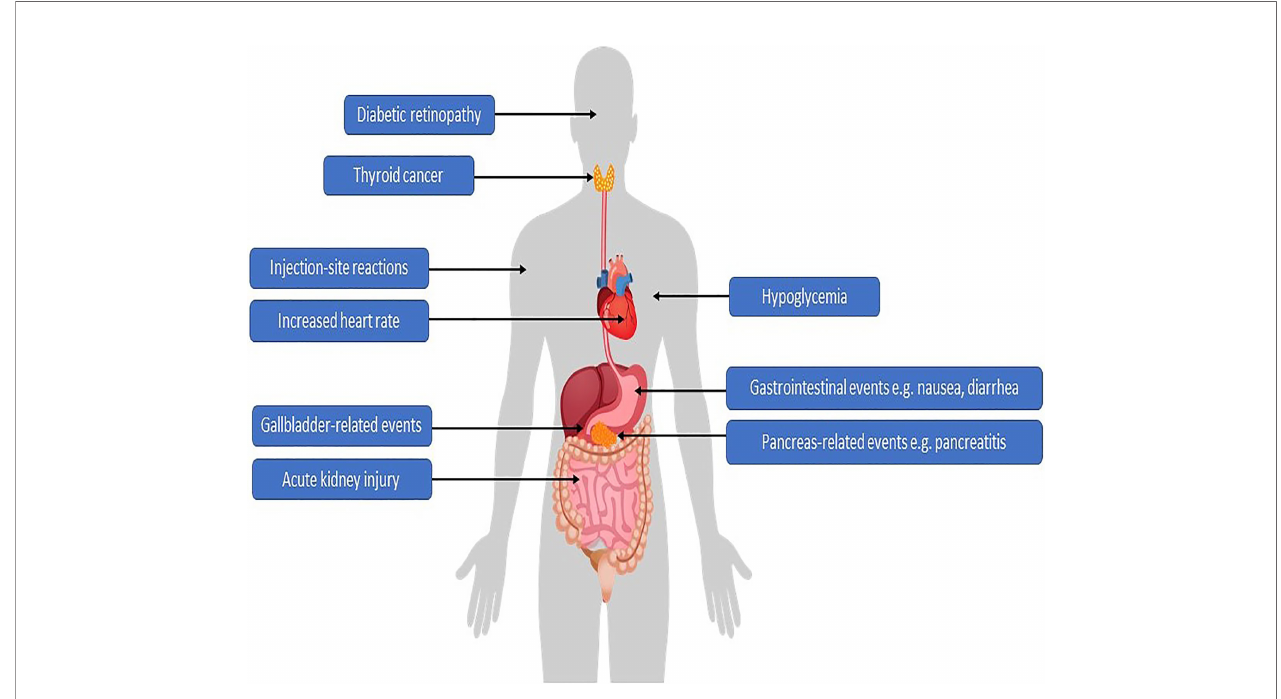
FIGURE 1 | Potential adverse effects associated with